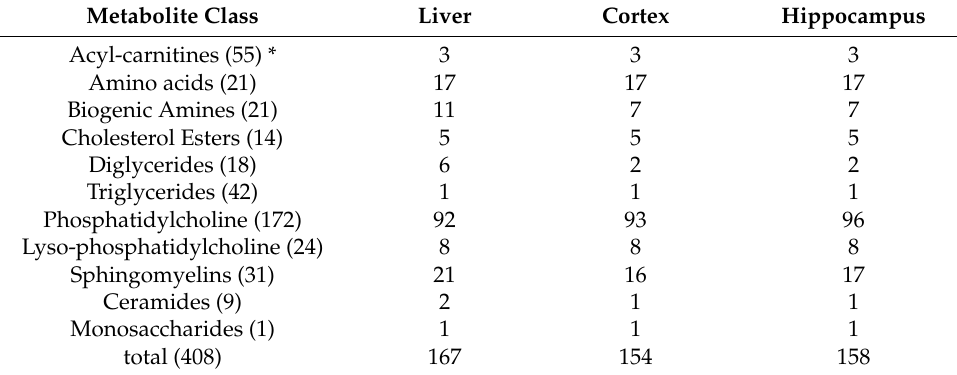
Table 1. Targeted Metabolomic compound distribution among metabolite